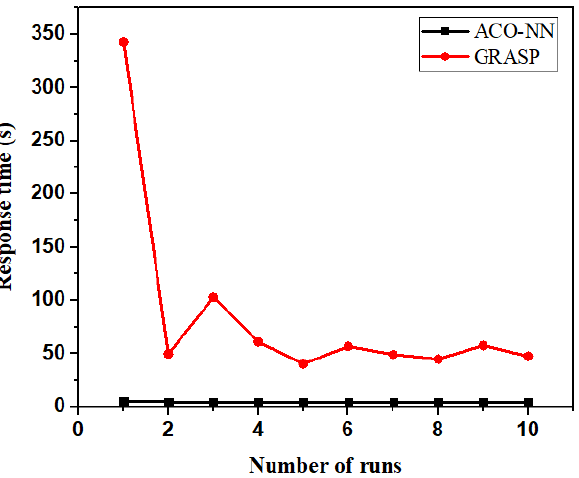
Figure 9. Comparison of ACO-NN with GRASP for Eil51 regarding response time